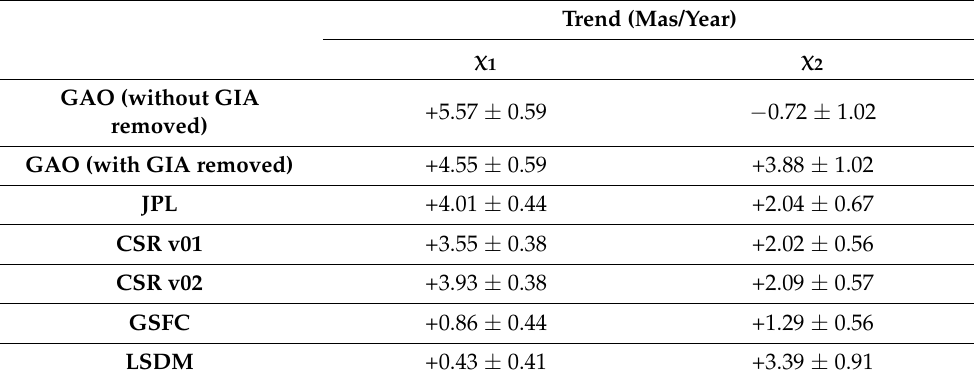
Table 2. Trends in the χ 1 and χ 2 components of GAO, GRACE-based hydrological plus cryospheric angular momentum (HAM/CAM), and Land Surface Discharge Model (LSDM)-based HAM together with their errors.